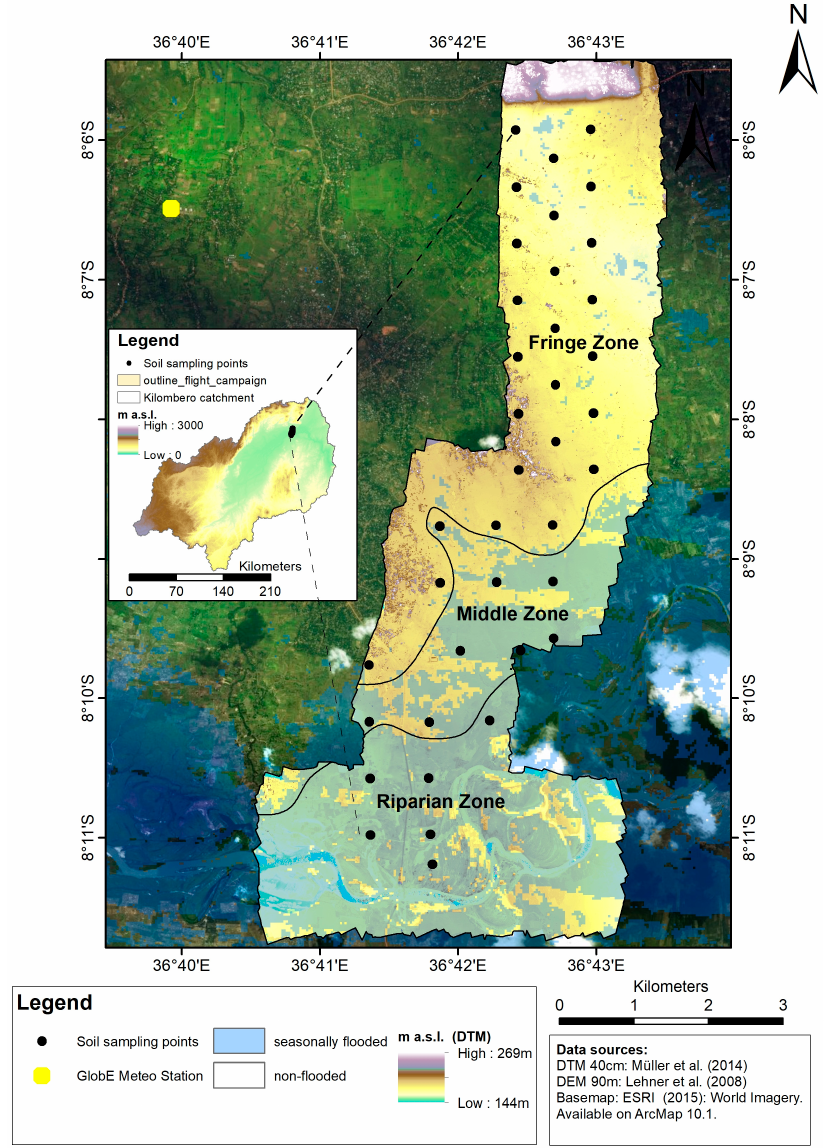
Figure 1. Study site and soil sampling locations along the three hydrological zones and the corresponding experimental sites of the GlobE project (riparian, middle, fringe).